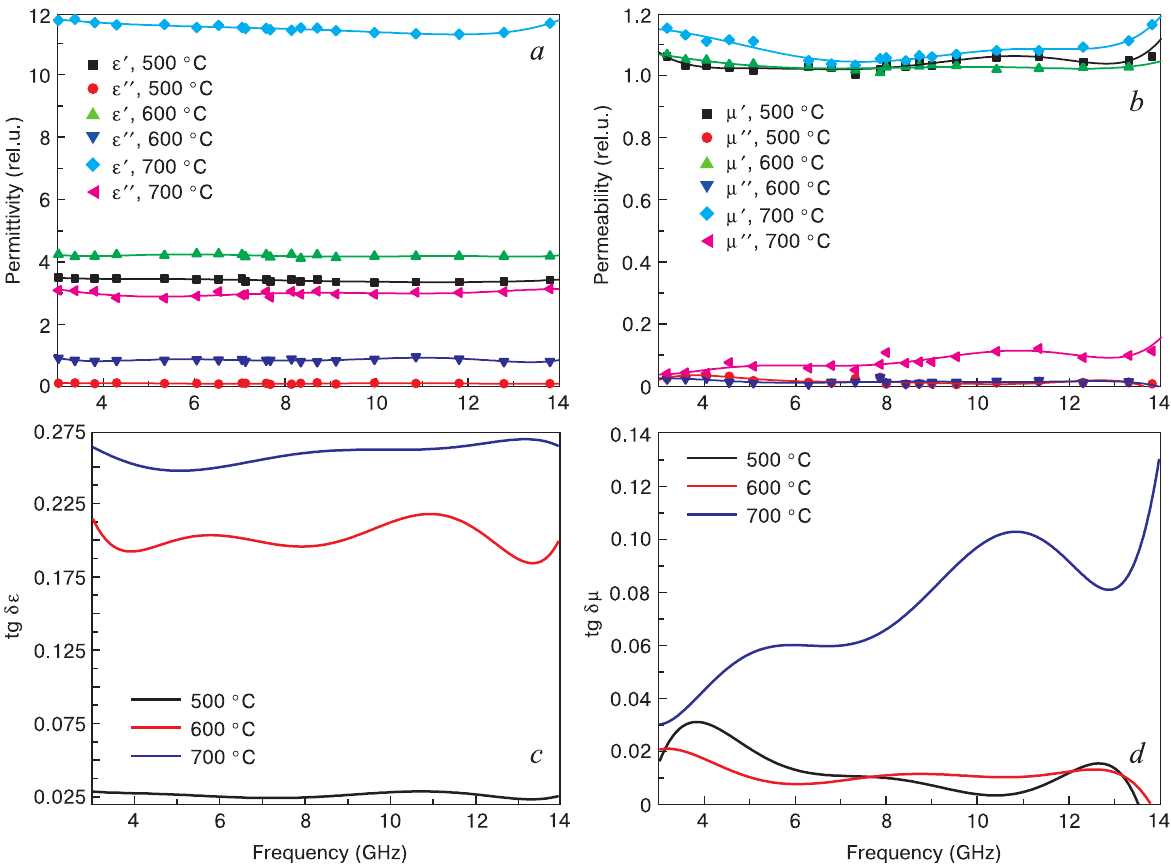
Figure 5. Frequency dependences of ( a ) complex permittivity and ( b ) permeability and tangents of ( c ) dielectric and ( d ) magnetic loss for different FeCoAl/C nanocomposite synthesis